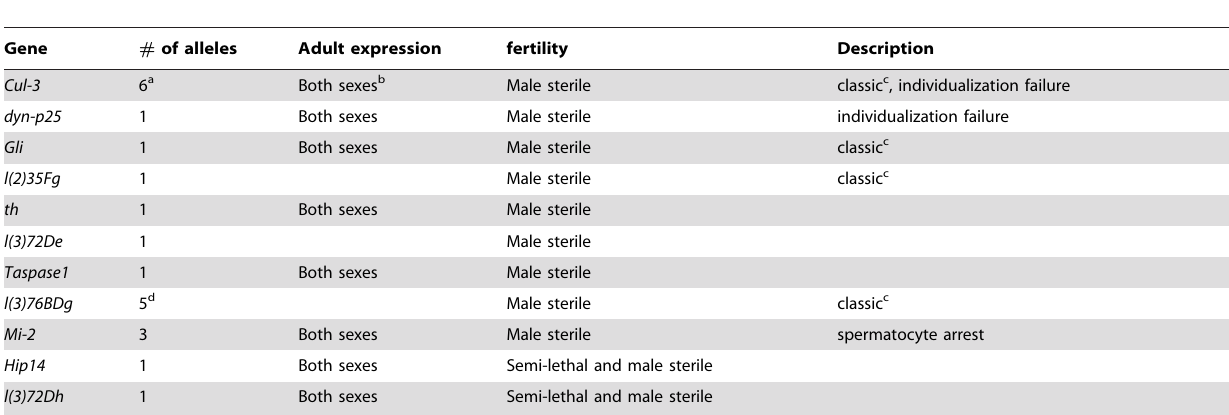
Table 3. Male-sterile alleles of vital genes from the Zuker collection.